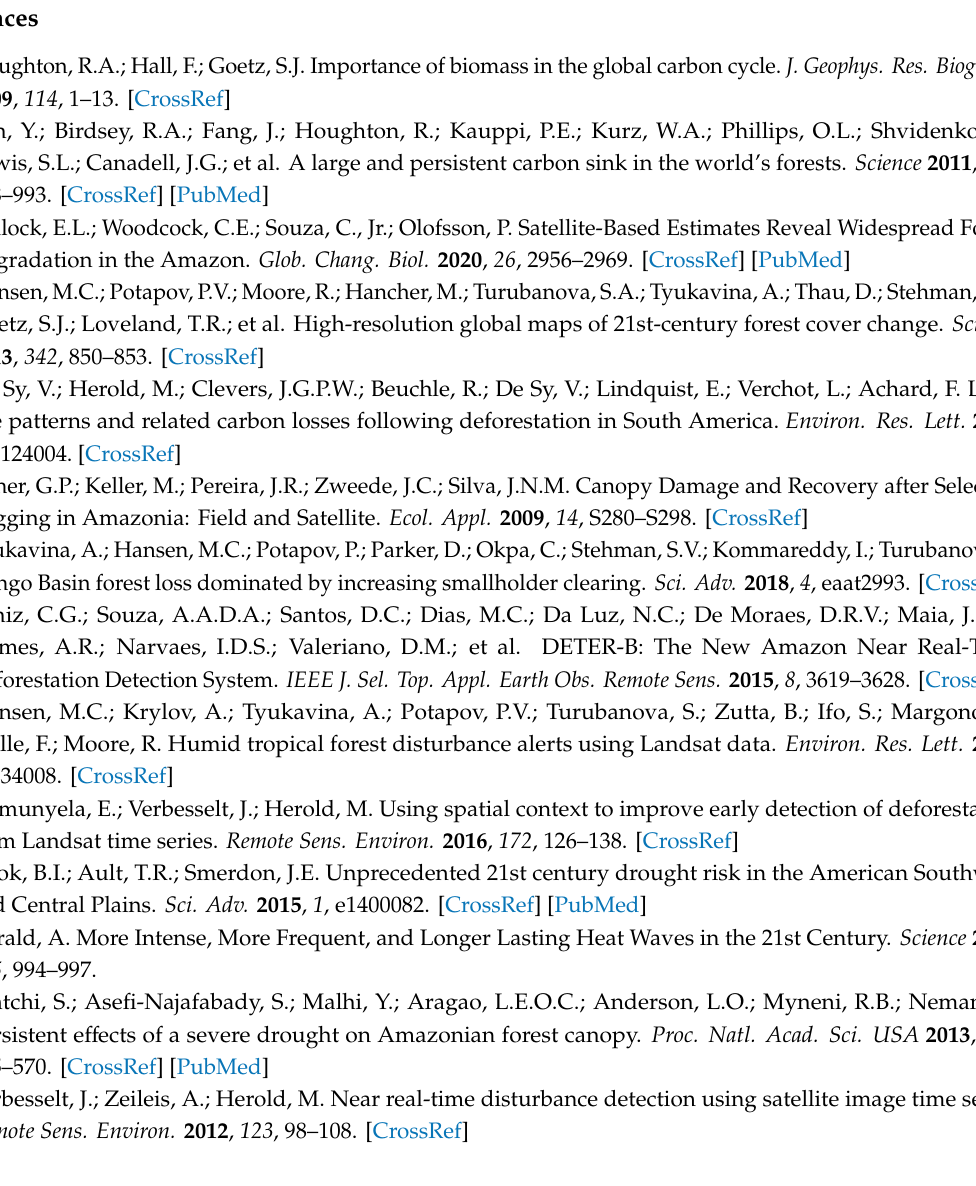
Figure A2. An example of regression model fitting difference between R (original BFASTmonitor) and in GEE (GEE BFASTmonitor) for the pixel time series of Landsat normalised difference moisture index at humid (Peruvian site) and dry (Bolivian site) tropical forest and Miombo woodland (Mozambican site).